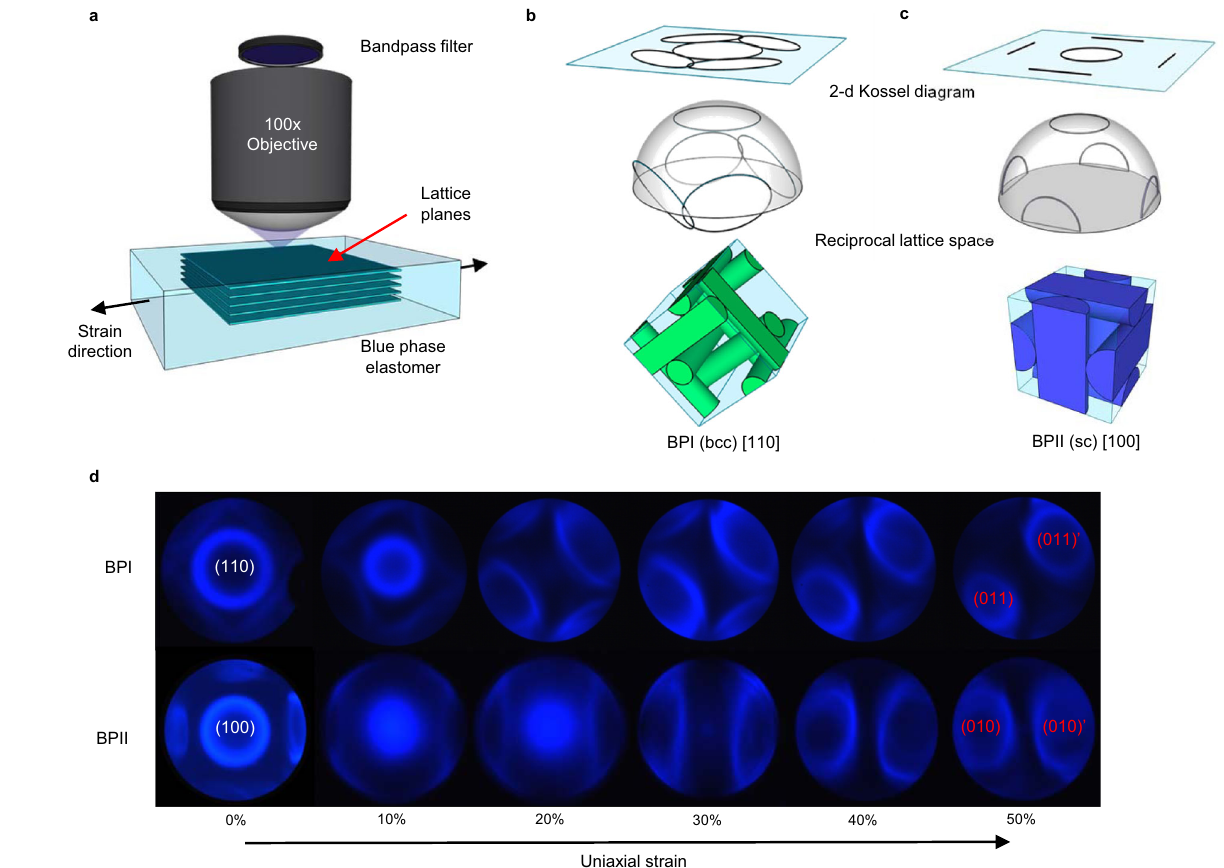
Fig. 3 Blue-phase LCE lattice deformation (Kossel diagram analysis). a Kossel diagram capture apparatus. A polarized optical microscope was employed with a Bertrand lens, a ×100 objective lens, and 440 nm bandpass fi lter. b Top: Theorized Kossel diagram of [110] oriented blue phase I. Middle: Reciprocal lattice space of [110] oriented blue phase I. Bottom: Unit cell of [110] oriented blue phase I. c Top: Theorized Kossel diagram of [100] oriented blue phase II. Middle: Reciprocal lattice space of [100] oriented blue phase II. Bottom: Unit cell of [100] oriented blue phase II. d Kossel diagrams of blue phase I (BPI) and blue phase II (BPII) elastomers as a function of (horizontal) uniaxial strain, showing unit cell recon fi